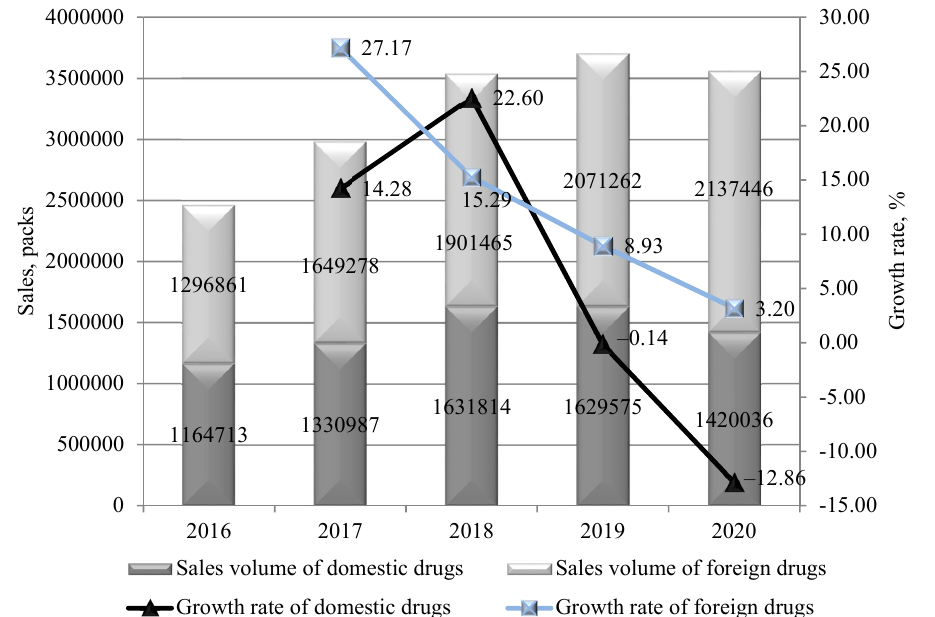
1. Dynamics of indicators of retail sales of antiepileptics in physical terms for the pharmaceutical market of Ukraine